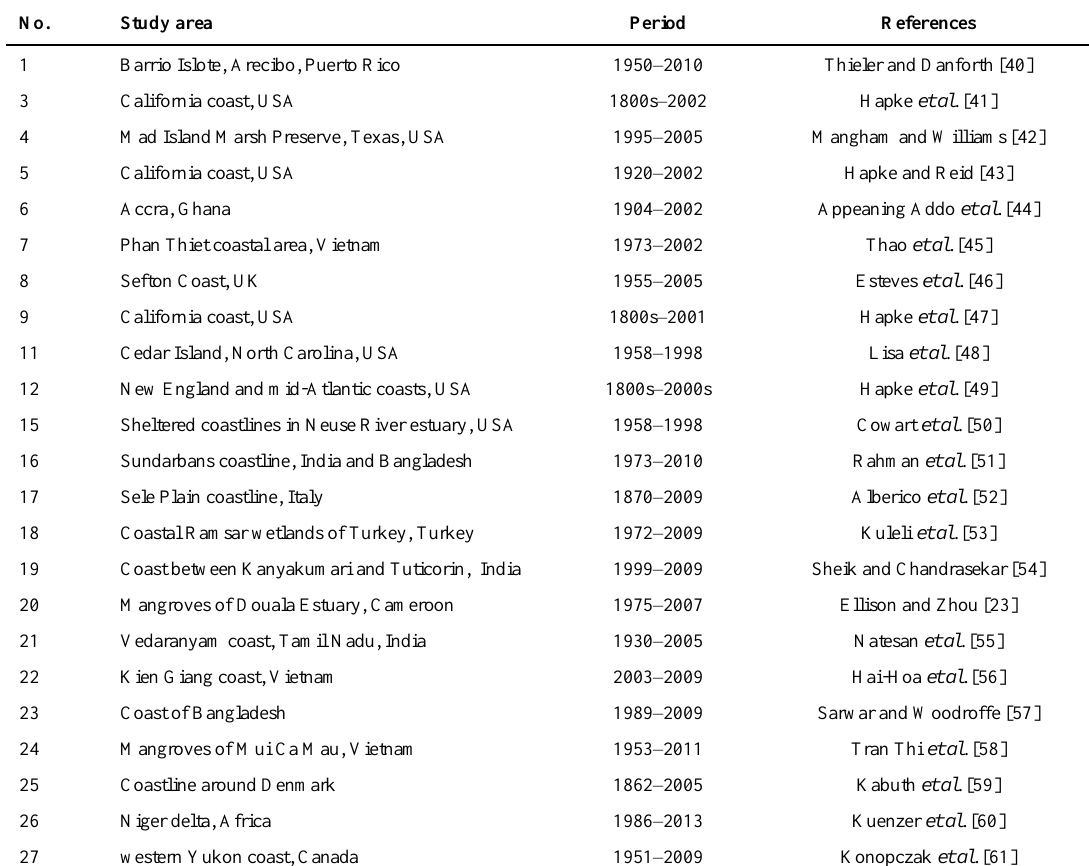
Table 1. Examples of studies carried out using DSAS to evaluate the rate of change in coastlines and borders of mangrove forests around the world No. Study area